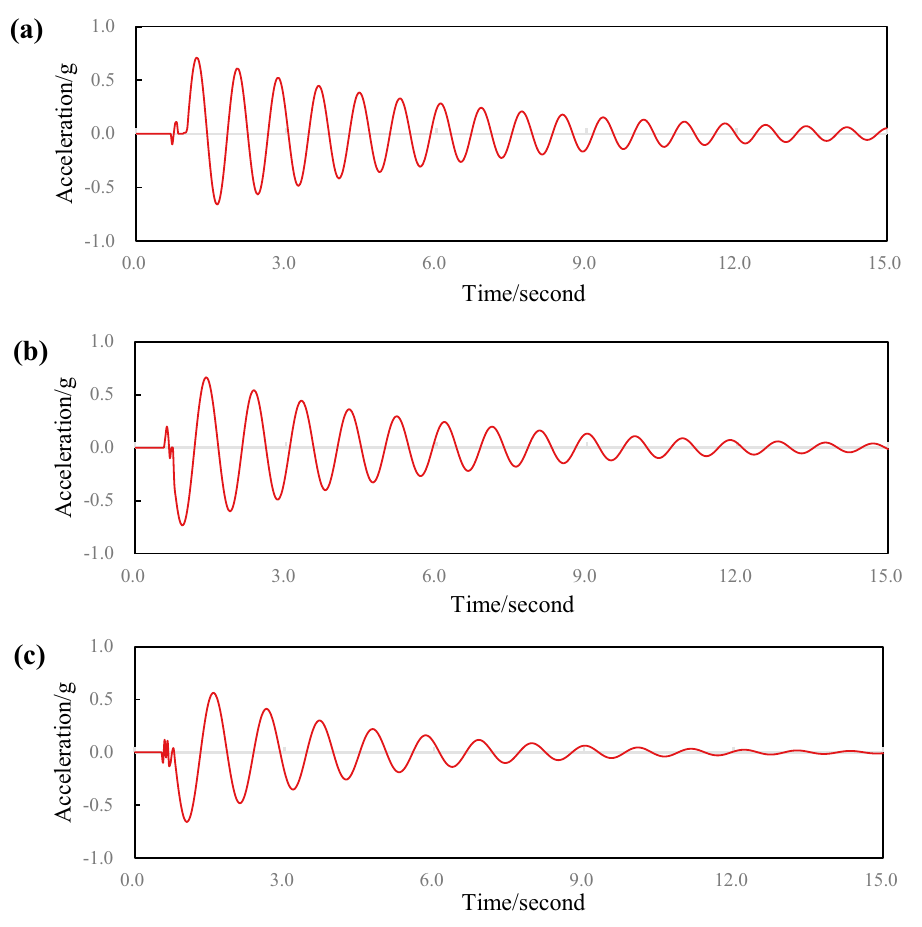
Figure 8. Variation curve of vibration attenuation of composite leaf springs with different laying angles; ( a ) specimen 1 test data; ( b ) specimen 2 test data; ( c ) specimen 3 test